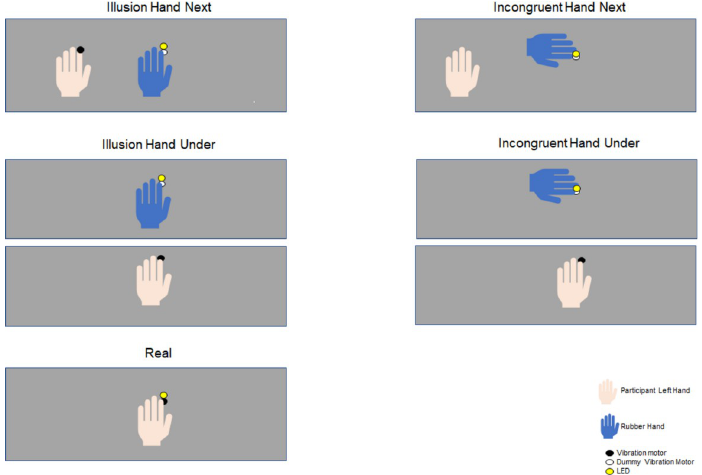
Fig 1. Schematic of the five experimental conditions. The two Illusion conditions were defined by the position of the participant’s own hand relative to the rubber hand in either the vertical or horizontal plane. Each Illusion condition was paired with its respective Incongruent control condition, derived by tilting the rubber hand by 90 degrees. In the Real condition the visuo- tactile stimulation was delivered on the participant’s hand and the rubber hand was absent.